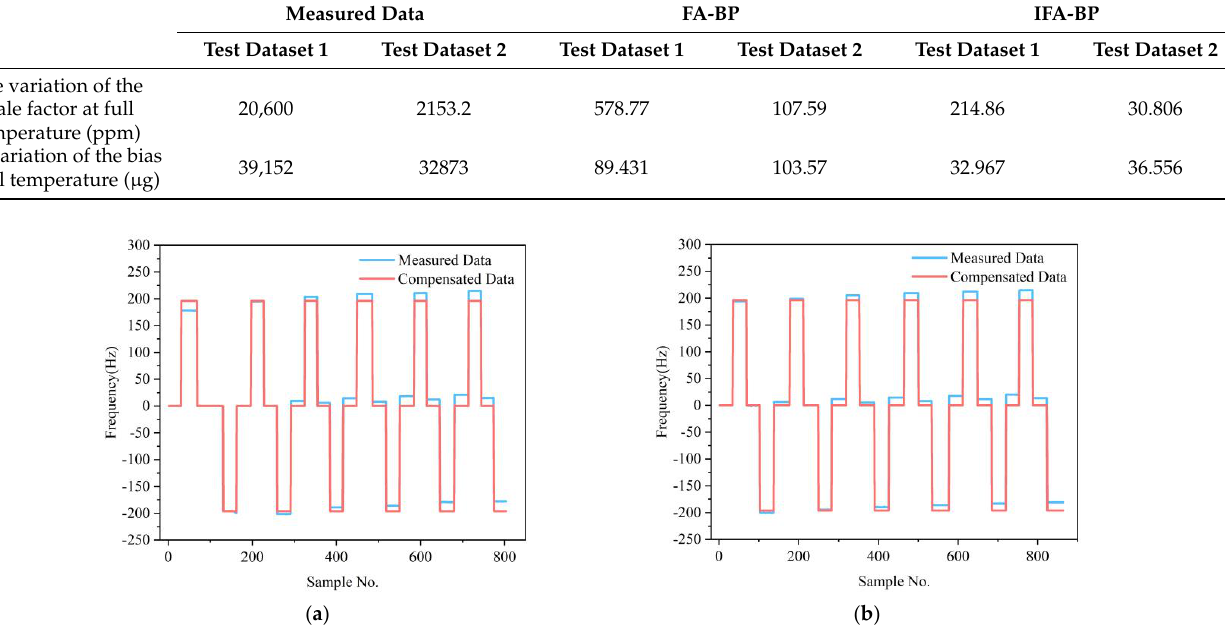
Figure 8. The IFA-BP compensation results of the accelerometer in the full-temperature experiment: ( a ) test dataset 1; ( b ) test dataset 2.